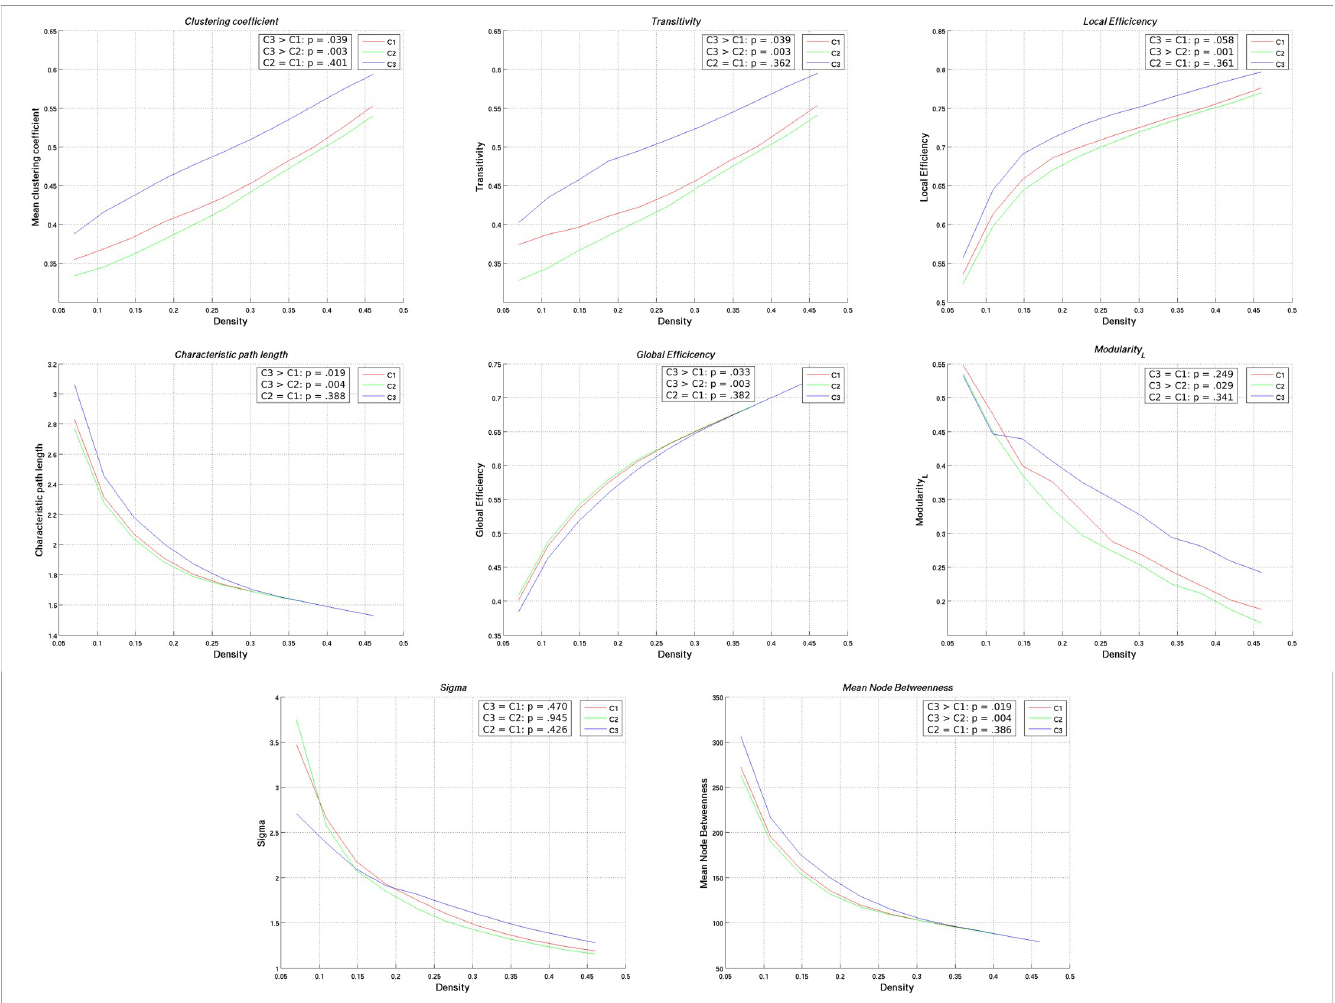
Fig 3. Functional data analysis curves for cortical thickness networks. Mean cortical thickness network coefficients for neurocognitive clusters plotted as a function of density. Cluster comparisons and p-values are derived from results of the Functional Data Analysis. Sigma = small-world.